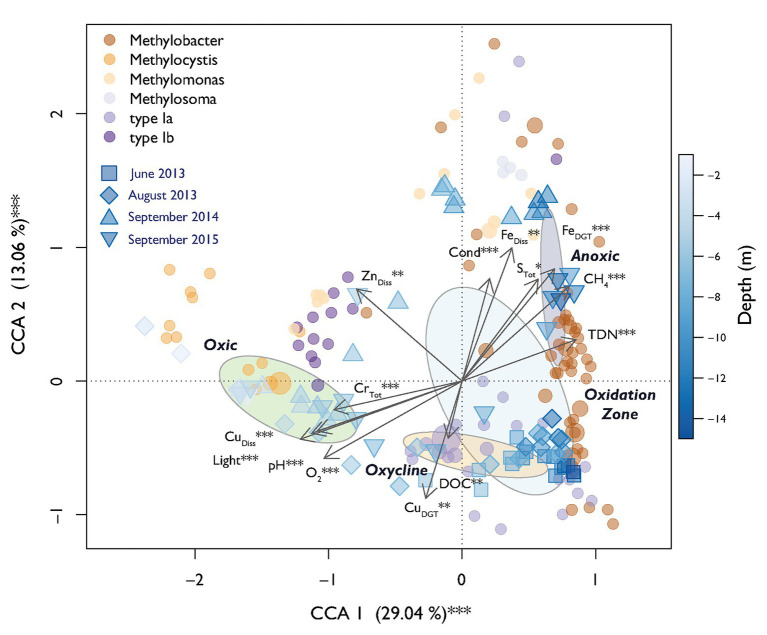
Canonical correspondence analysis (CCA) biplot of relative MOB (pmoA) abundance. Dots indicate specific MOB OTUs and are colored according to their taxonomic affiliation. The diameter of the dots is relative to the square root of the sums of the read counts standardized to the mean sequencing depth. Squares and triangles depict scores of specific sampling depths during different sampling dates. The fill color declares the depth of the respective sample according to the depicted color gradient. Dispersion ellipses show standard errors of weighted average scores of depth zones (confidence limits = 0.95). Environmental variables are fitted as arrows and the explained variance for canonical correlation analysis (CCA) axes 1 and 2 are given. Asterisks represent significance of permutational ANOVAS of the single variables and axes (**
p < 0.01, ***
p < 0.001).